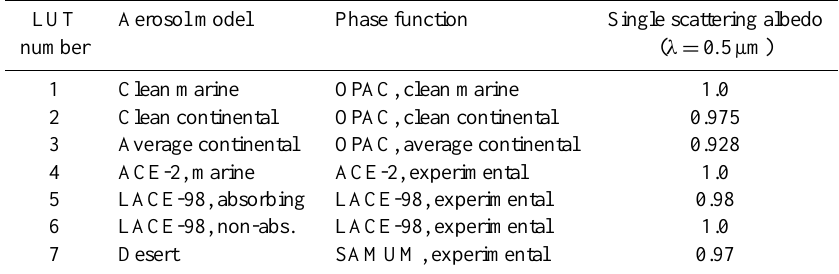
Table 3. Look-up-tables in use and their characteristics. LUT